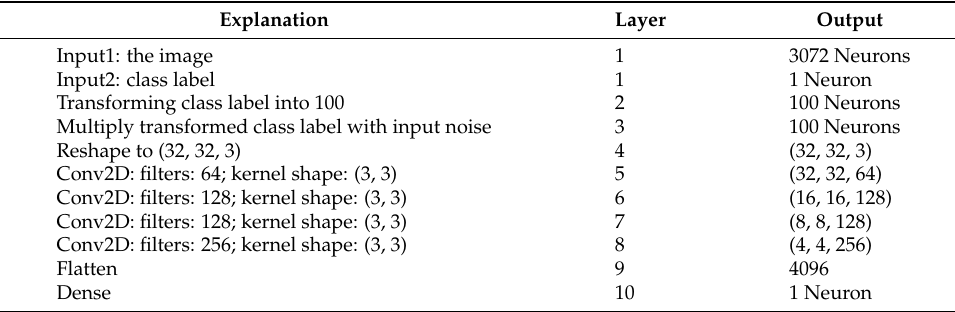
Table A4. The architecture of the discriminator used for the cifar10-based